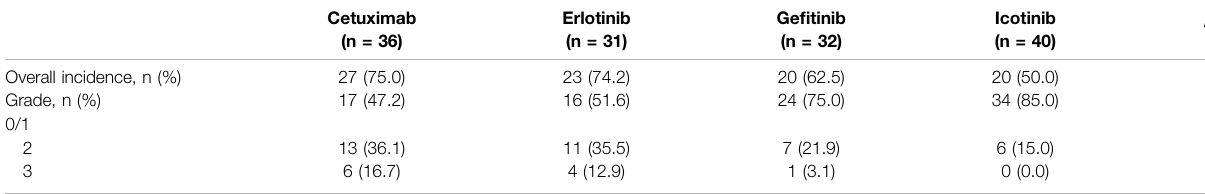
TABLE 3 | Incidences and gradings of acneiform rashes with different EGFRIs treatment. Cetuximab Erlotinib